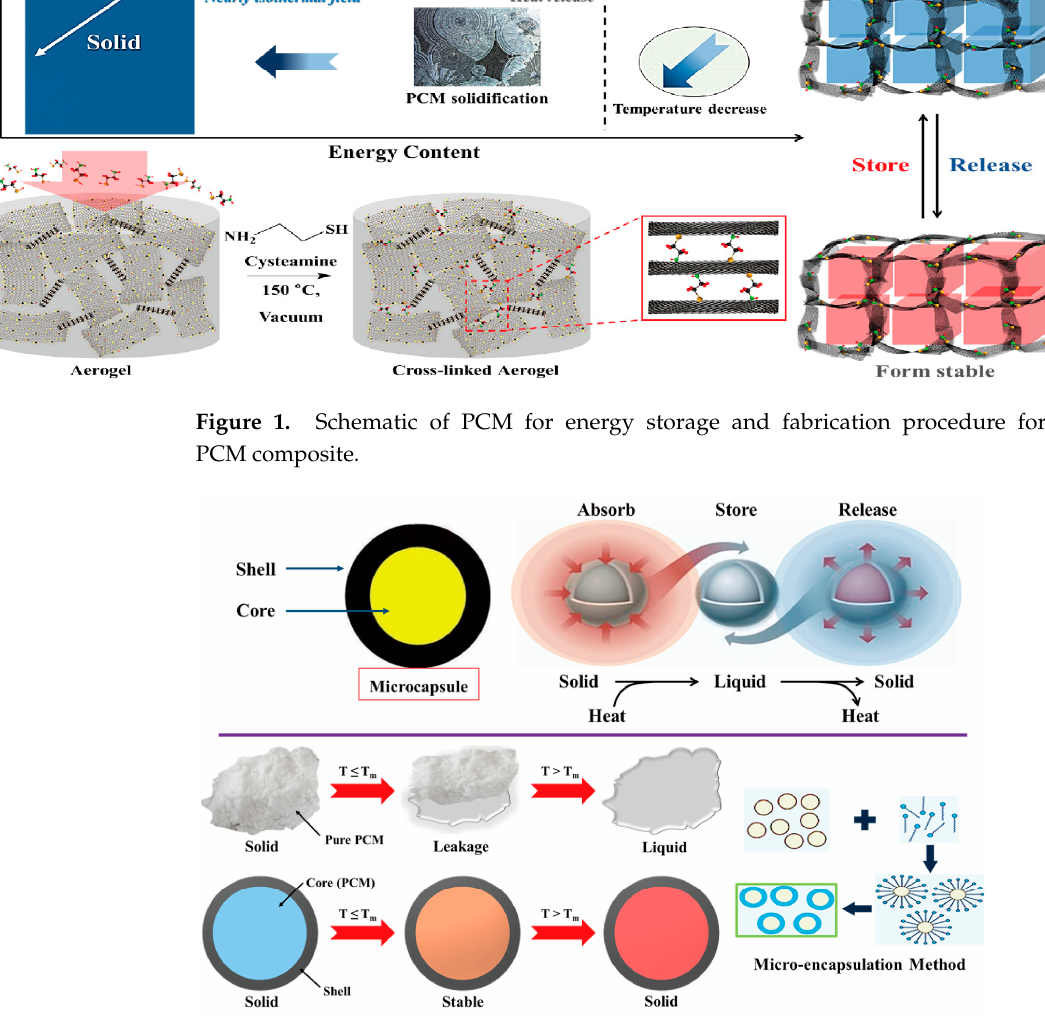
Figure 2. Illustration of working mechanism of microencapsulated form stable PCM